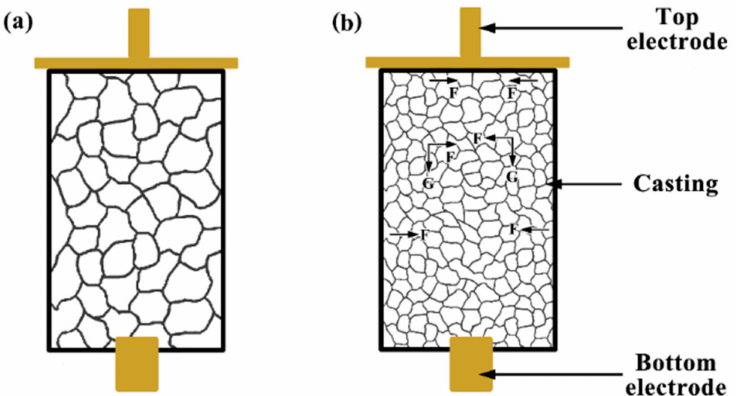
Figure 7. The schematic explanation to the e ff ect of the weak AECP on grain refinement: ( a ) Without AECP; ( b ) under